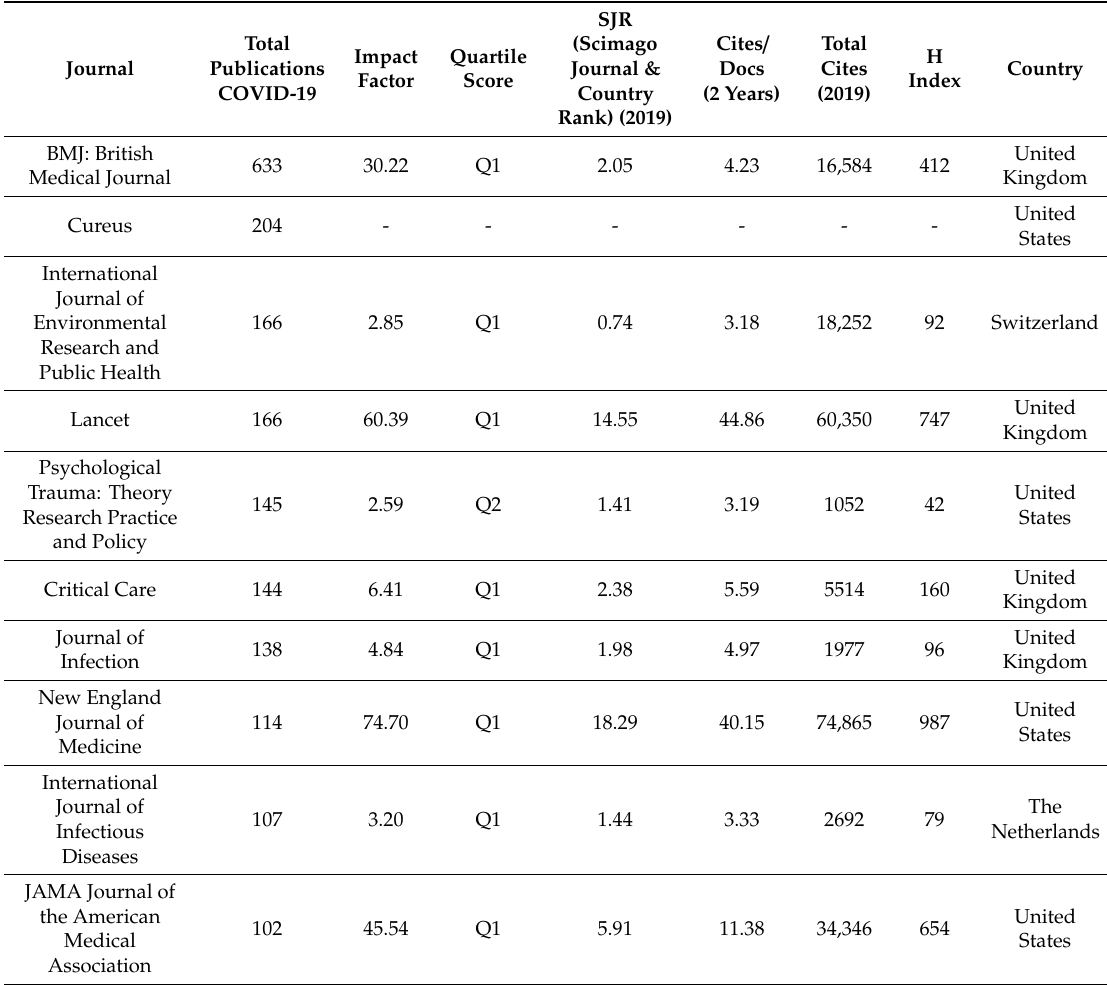
Table 2. Top 10 journals with the most publications.